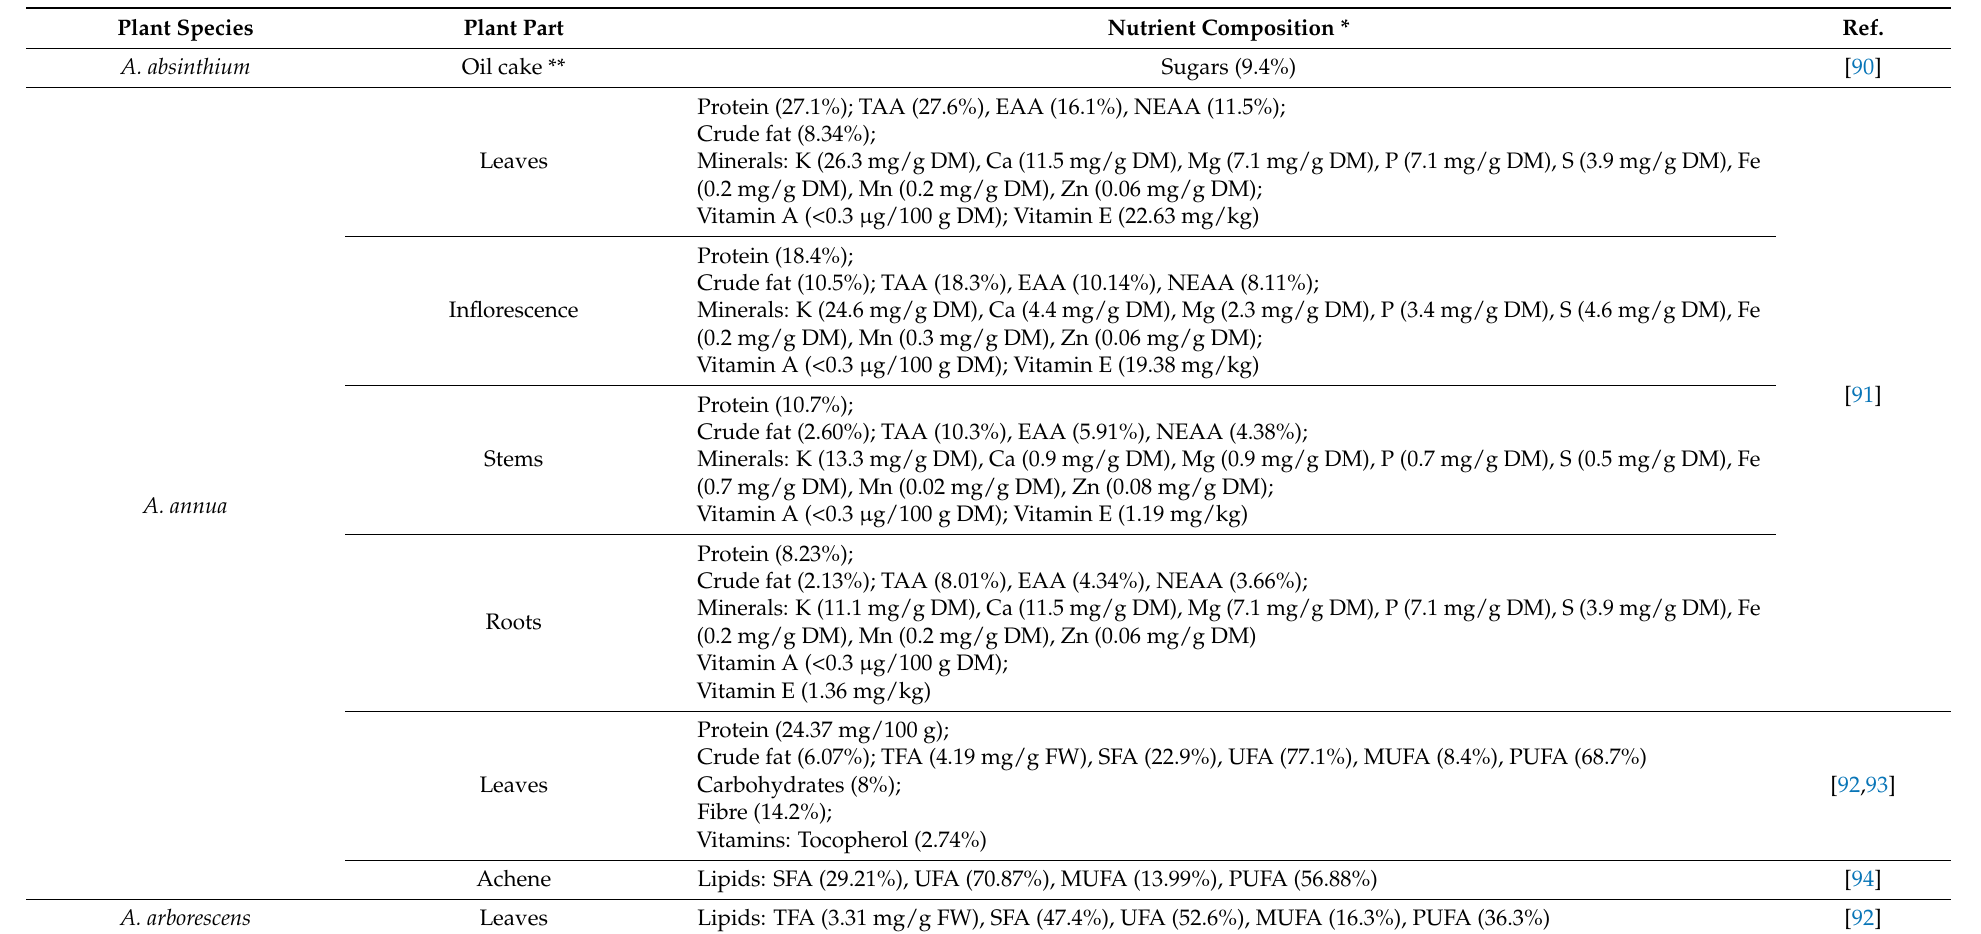
Table 2. Nutritional composition of some edible Artemisia